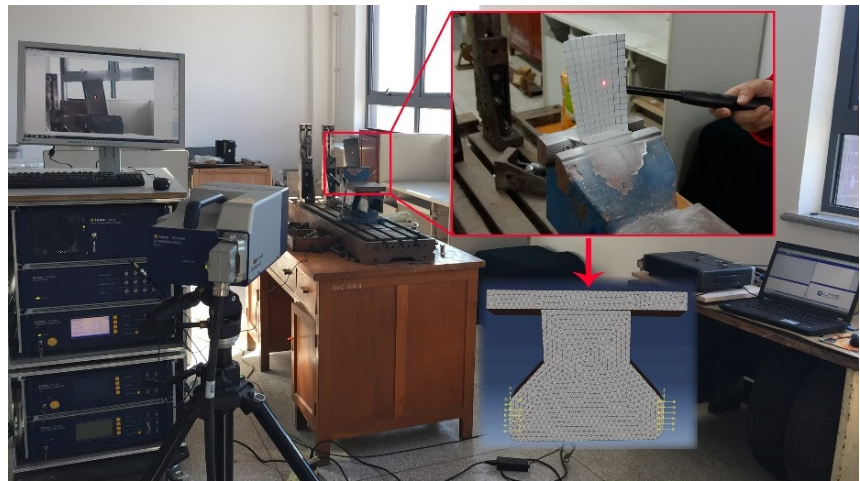
Figure 4. The blade FE model and constrain conditions.